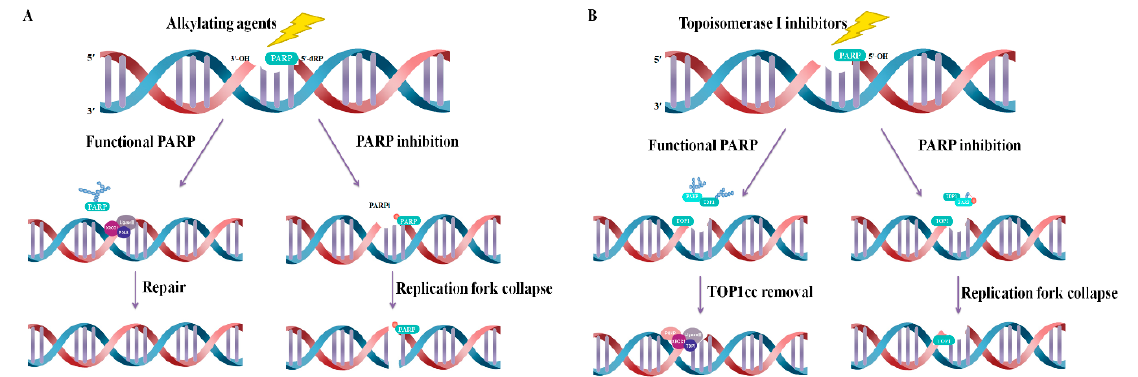
Figure 3. Principle of combination therapy with chemoagents, based on trapping effects and inhibition of catalytic activity. ( A ) An alkylating agent forms a single-nucleotide gap with 5'-deoxyribose phosphate (5-dRP). PARP1/2 senses and binds it, inducing recruitment of BER molecules. A PARP inhibitor prevents repair by inhibiting dissociation of PARP via trapping the PARP-DNA complex, which is PARP bound to 5-dRP. ( B ) TOP1cc, a covalent binding state of TOP1 induced by Top1 and a DNA 3 ′ -end, is repaired by TDP1 recruited to TOP1cc by PARylation and PAR transferase of PARP1 to induce TOP1-DNA complex excision. Topoisomerase I inhibitors continuously induce TOP1cc. PARP inhibitors inhibit catalytic activity, suppressing the recruitment of TDP1 and TOP1-DNA covalent complex repair, resulting in a synergistic effect.